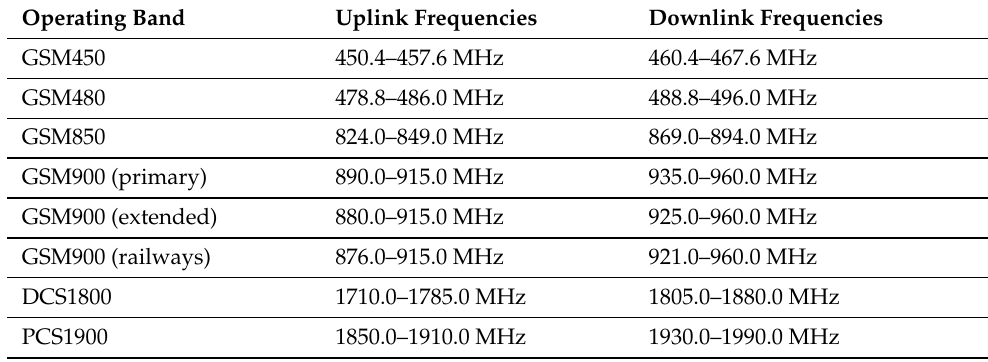
Table 1. GSM frequency